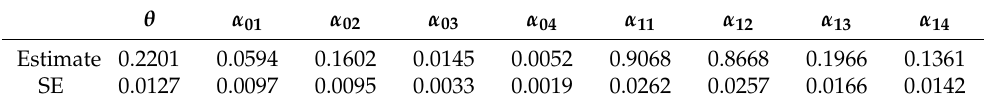
Table 3. Estimates of parameters of the latent class model for the association between the sensitive characteristic variable from question 39: “Have you ever had a one-night stand through a dating site or mobile app?”, and the four observed dichotomized random variables for online dating experience corresponding to selected statements 43, 45, 55, and 61 by the likelihood ratio test at α = 0.1. θ α 01 α 02 α 03 α 04 α 11 α 12 α 13 α 14